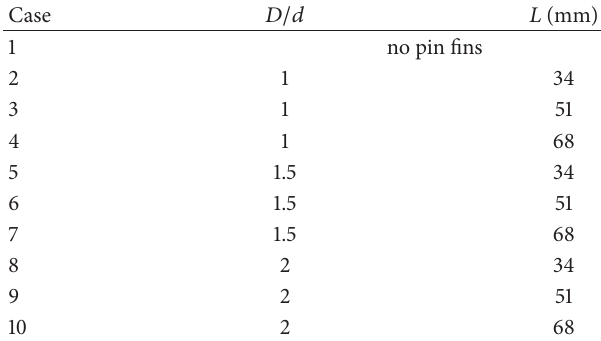
Table 2: Cases number for different geometric